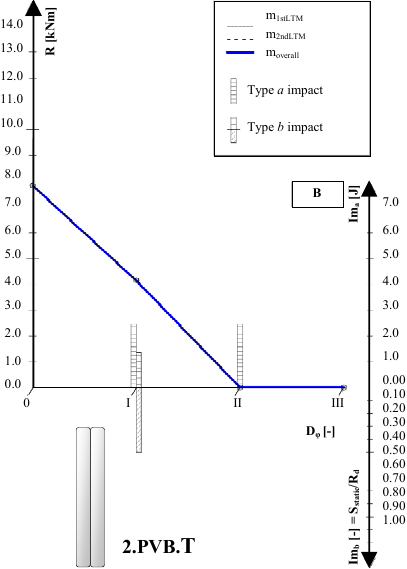
Figure 6: Element Safety Diagram for triple layer, PVB-laminated, annealed glass